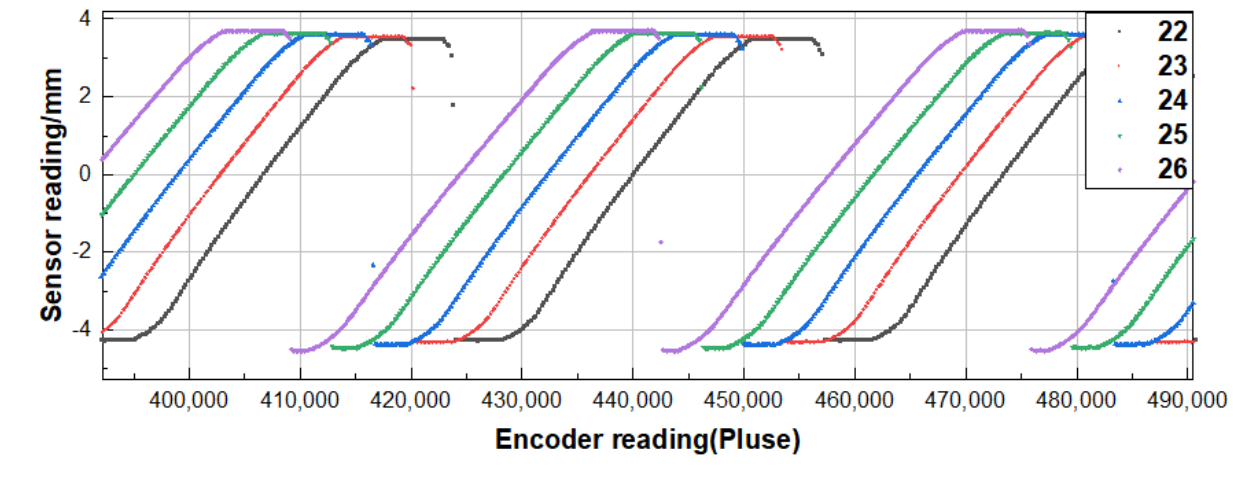
Figure 12. Measurement graphs for different offsets.